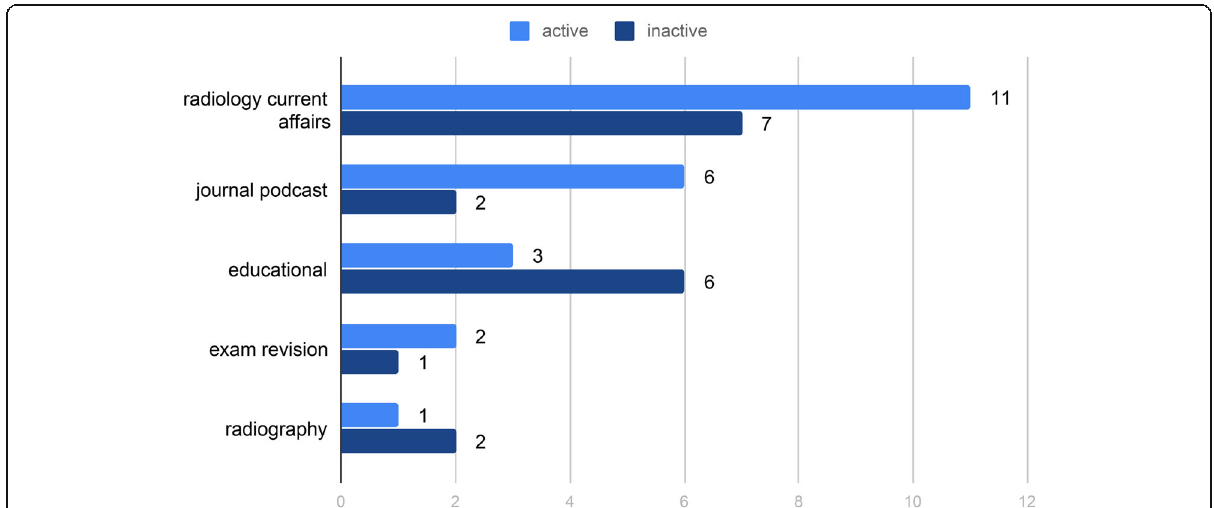
Fig. 4 Podcast series by category and whether active or inactive. A bar chart showing the number of podcast series in each subject category and whether active or